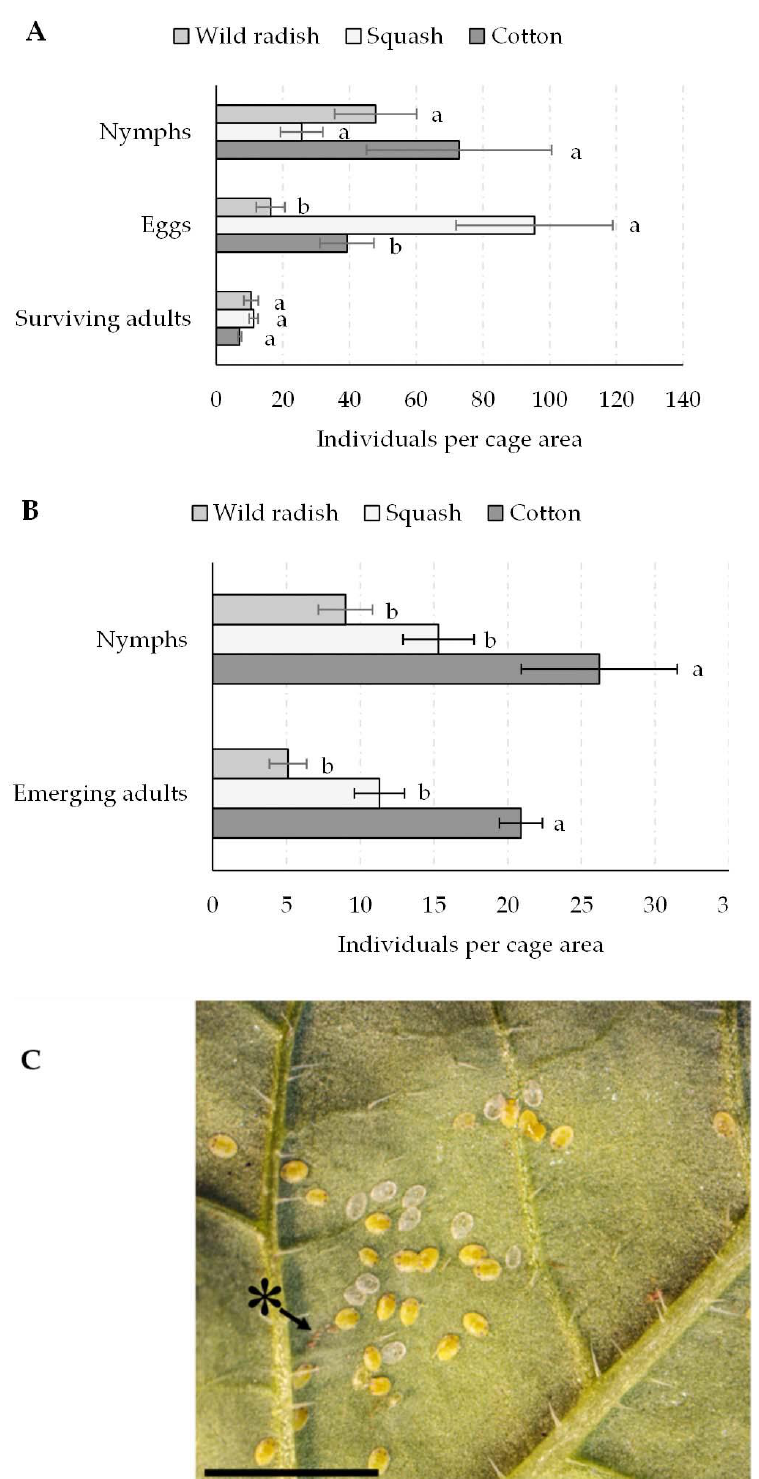
Figure 5. Whitefly numbers by stage on wild radish, squash, and cotton after 48 h in a clip cage on the top expanded leaf ( A ) and nymphs and adults produced after 1 and 2 weeks, respectively, in a tube cage with a plant with two expanded leaves ( B ) The statistical difference is represented as ‘a’ and ‘b’. Different immature stages of Bemisia tabaci and exuviae left from emerged adults on Raphanus raphanistrum leaf abaxial surface. * = eggs; bar = 5 mm ( C ).